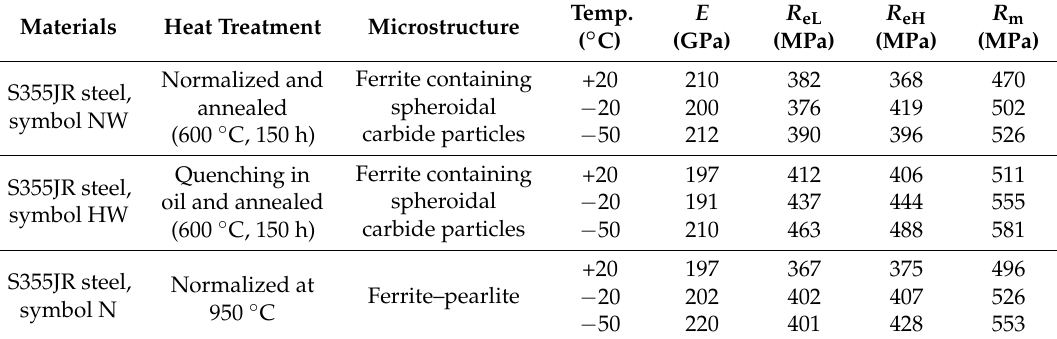
Table 1. The mechanical properties of the materials tested in the research